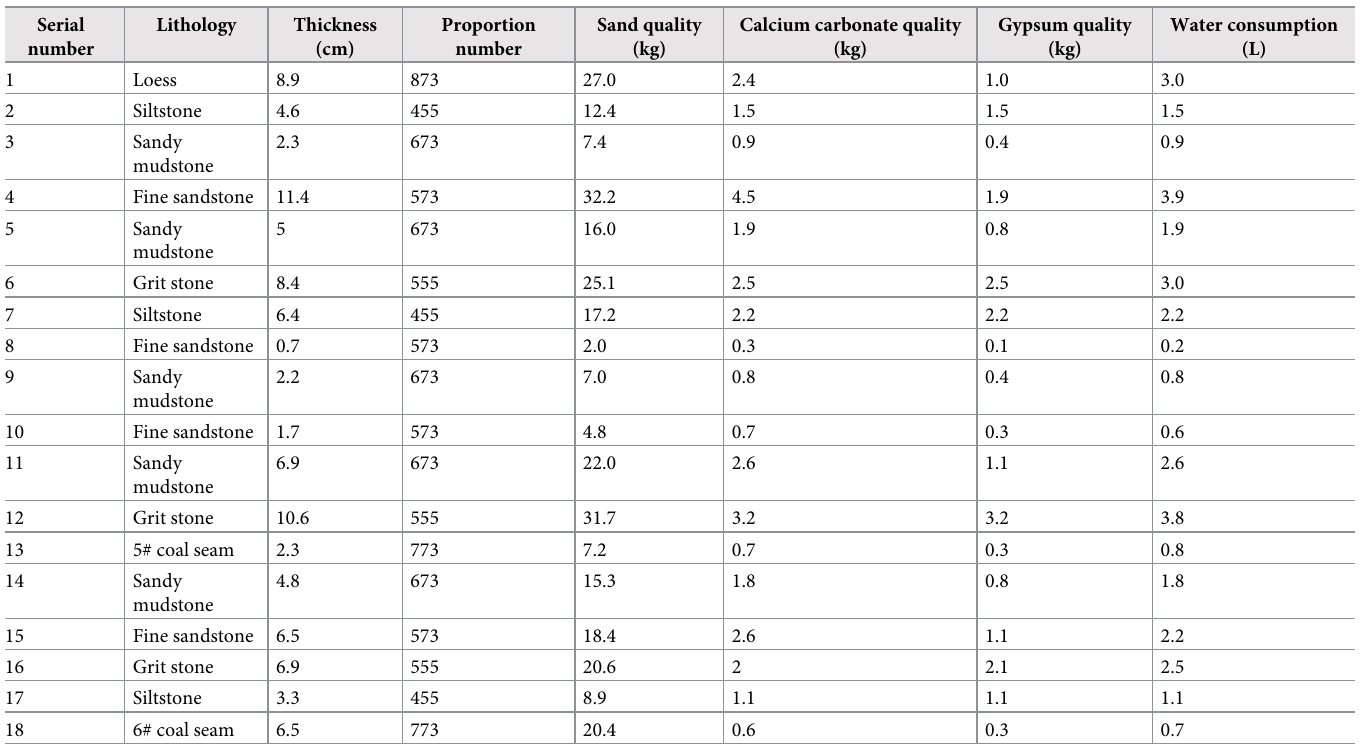
Table 1. Similar model parameters and